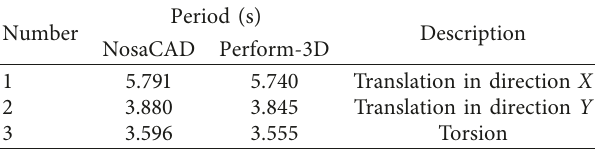
Table 1: Natural vibration characteristic.